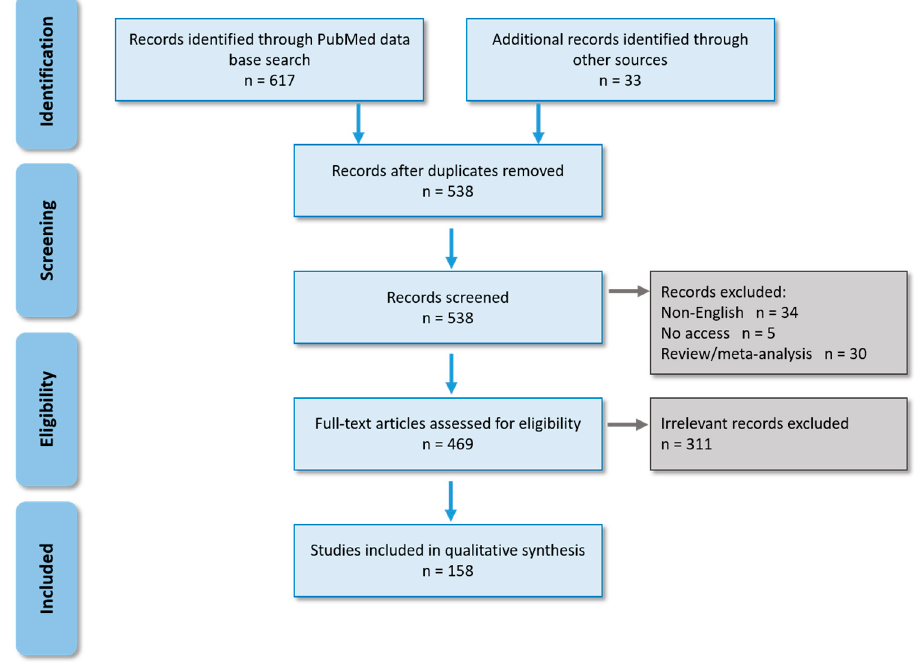
Figure 1. PRISMA flow chart [25] for systematic search of relevant publications.